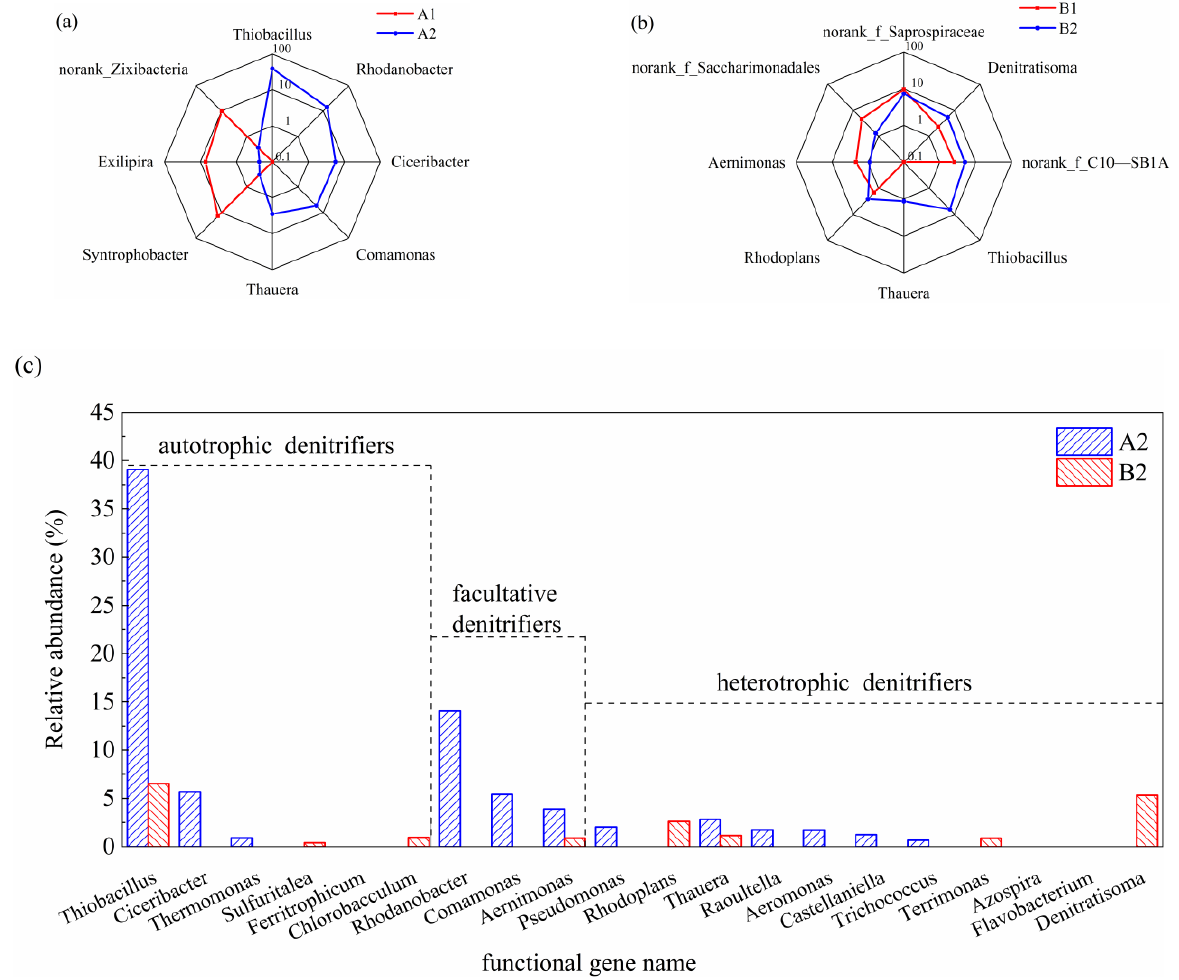
Figure 5. Transformation of functional genus from sludge ( a ) A1 to A2, ( b ) B1 to B2, and ( c ) differences of functional microbial genus in different denitrification systems.